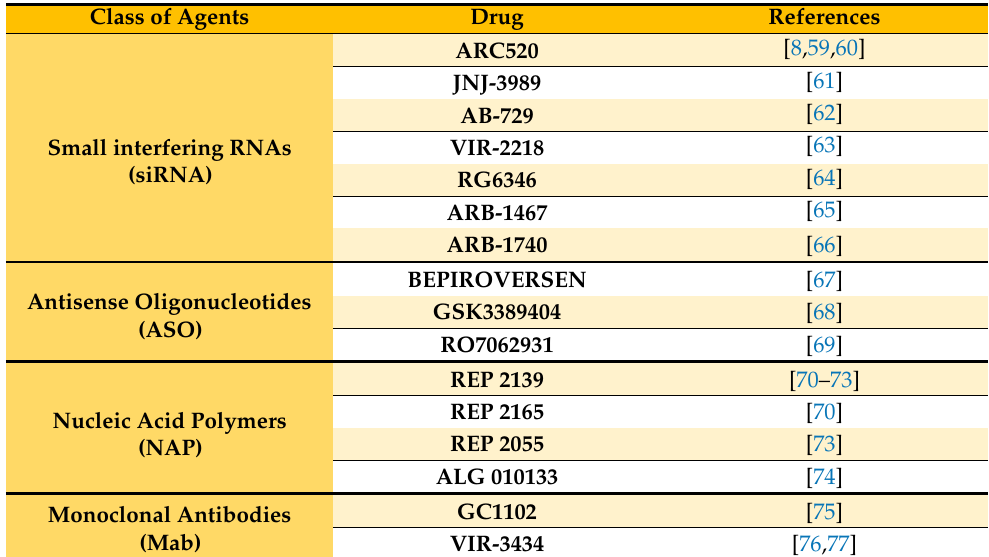
Table 1. Novel approaches tested in clinical trials for the reduction of antigen load in chronic HBV infection. Class of Agents